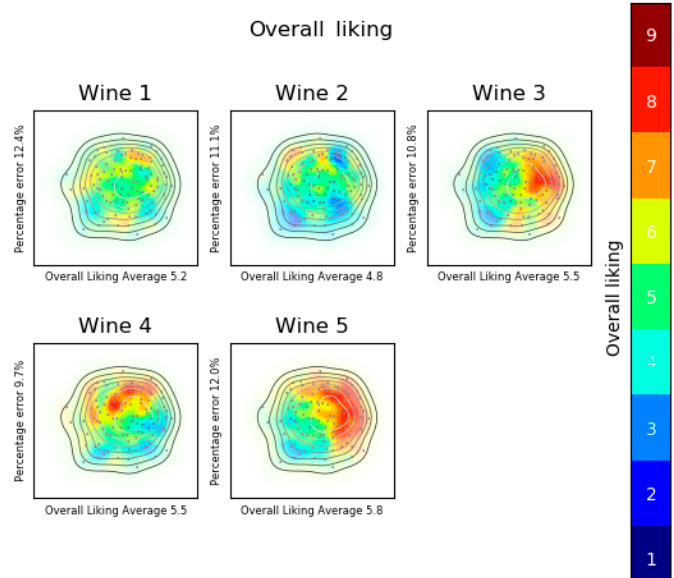
Figure 8. Overall liking analysis. Liking product landscape, consumers’ map created with MDS fed with OLJAR (overall liking (OL), the sensory perceptions (JAR) or both of them (OLJAR)) and product acceptance map created with SVM. Wine 1: Dry, dense and astringent; wine 2: Sweet, acid and fruity; wine 3: Sweet and dense; wine 4: Fruity, dry and light; and wine 5: Fruity, sweet and dense.